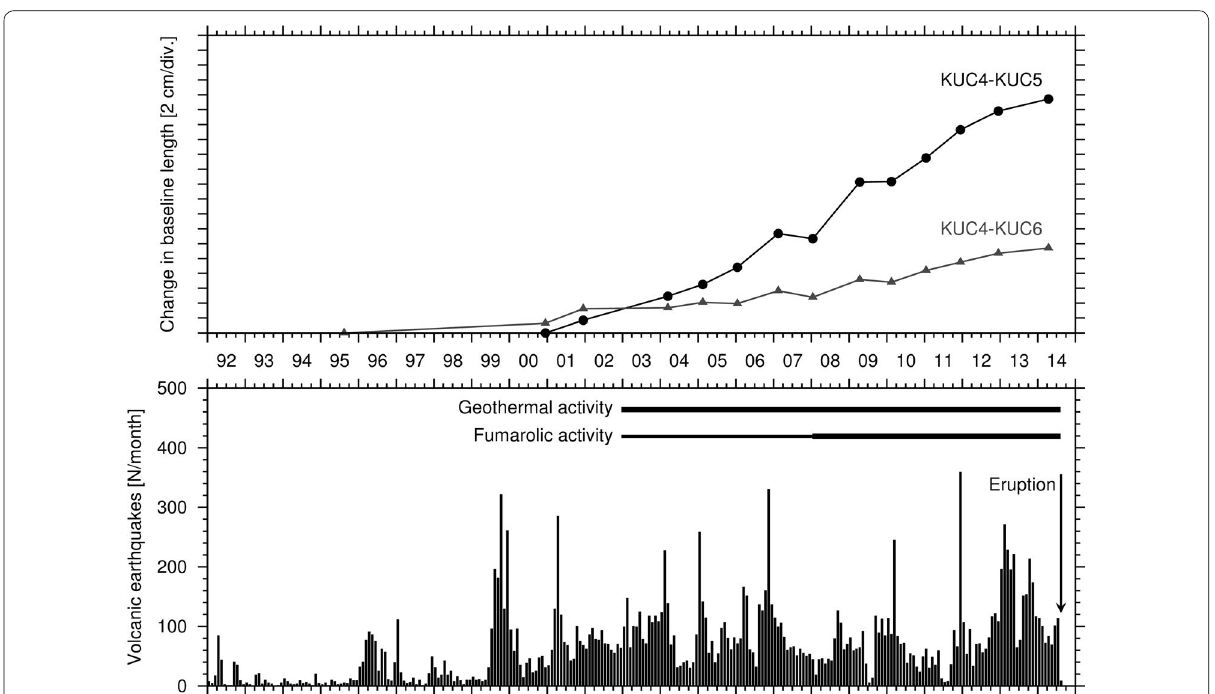
Fig. 2 Changes in baseline length (top) and monthly number of volcanic earthquakes with indication of geothermal and fumarolic activities (bot- tom) between 1992 and 2014